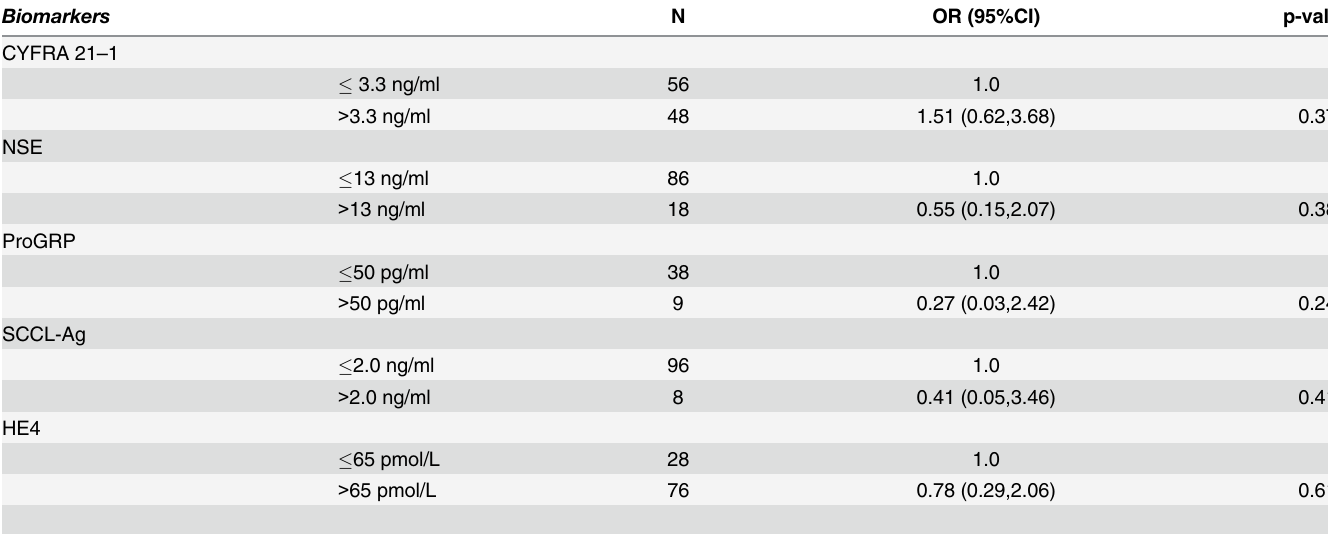
Table 3. Univariate logistic regression analysis for association of biomarkers with presence of brain metastasis at baseline.